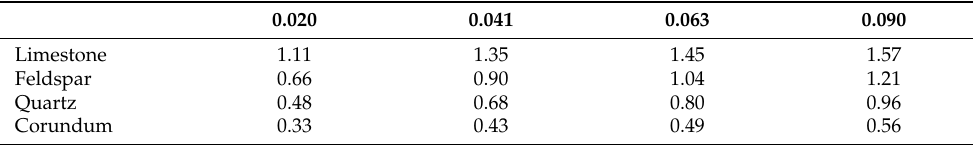
Table 11. Calculated k VTI (LG) (-) indexes according to Equation